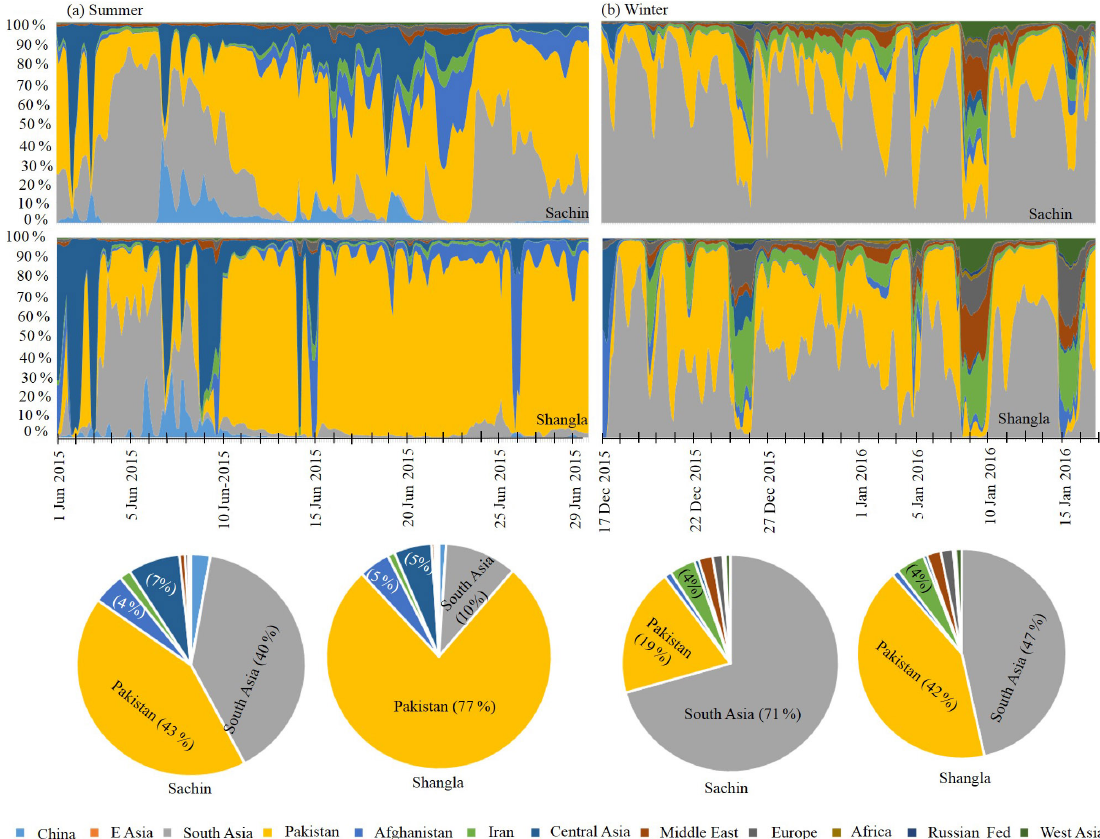
Figure 7. Source contribution regions of carbon monoxide for selected sites identified by WRF-STEM during (a) summer and (b)